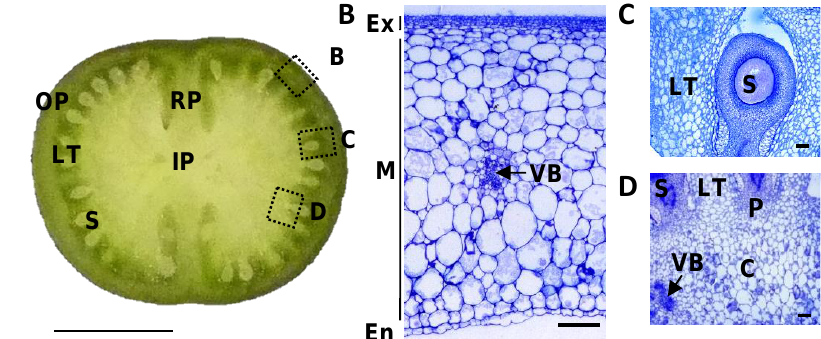
Figure 1. Structure of a tomato developing fruit. ( A ) Equatorial section of Ailsa Craig 12 days post-anthesis (DPA) fruit. The dotted squares indicate the position of fruit zones presented in B–D figures. Bar = 1 cm. ( B ) Outer pericarp of 12 DPA fruit. Bar = 200 µ m. ( C ) Locular tissue of 12 DPA fruit. Bar = 200 µ m. ( D ) Inner pericarp of 12 DPA fruit. Bar = 200 µ m. OP, outer pericarp; RP, radial pericarp; LT, locular tissue; S, seed; IP, inner pericarp; Ex, exocarp; M, mesocarp; En, endocarp; VB, vascular bundles; C, columella; P, placenta.